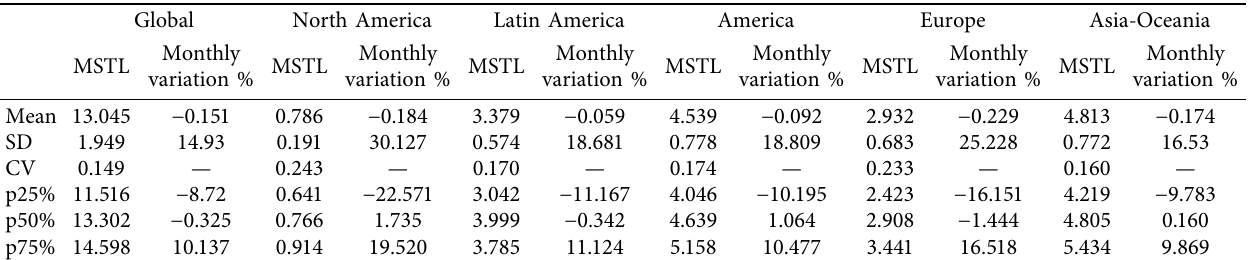
Table 2: Descriptive statistics of minimum spanning trees length by region (MSTLR) and global (MSTLG) measure.